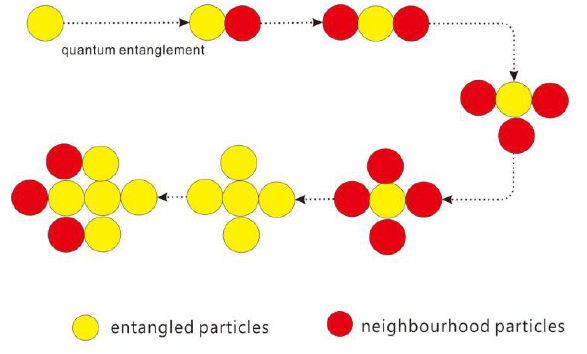
Figure 2. Process of Quantum entanglement